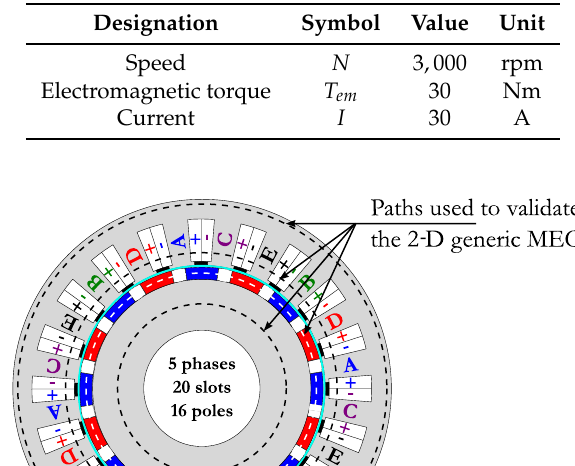
Table 2. Physical data of the machine.